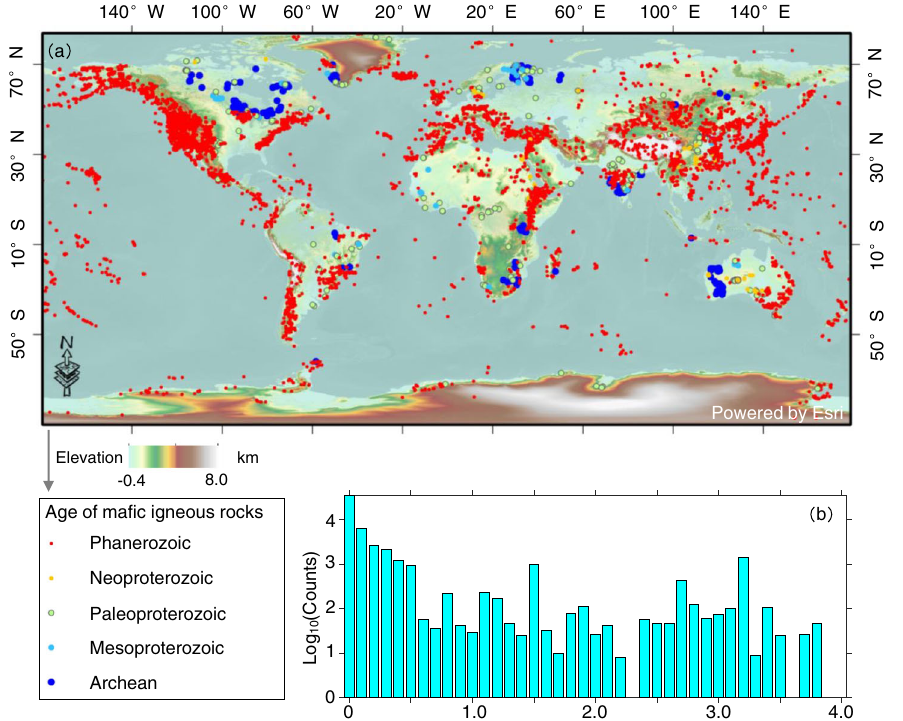
Fig. 2 | Spatiotemporal distribution of ma fi c igneous rock samples. a Spatial distribution of global data compilation of whole rock ma fi c igneous compositions from the EarthChem, GEOROC, and USGS data repositories. The map was created